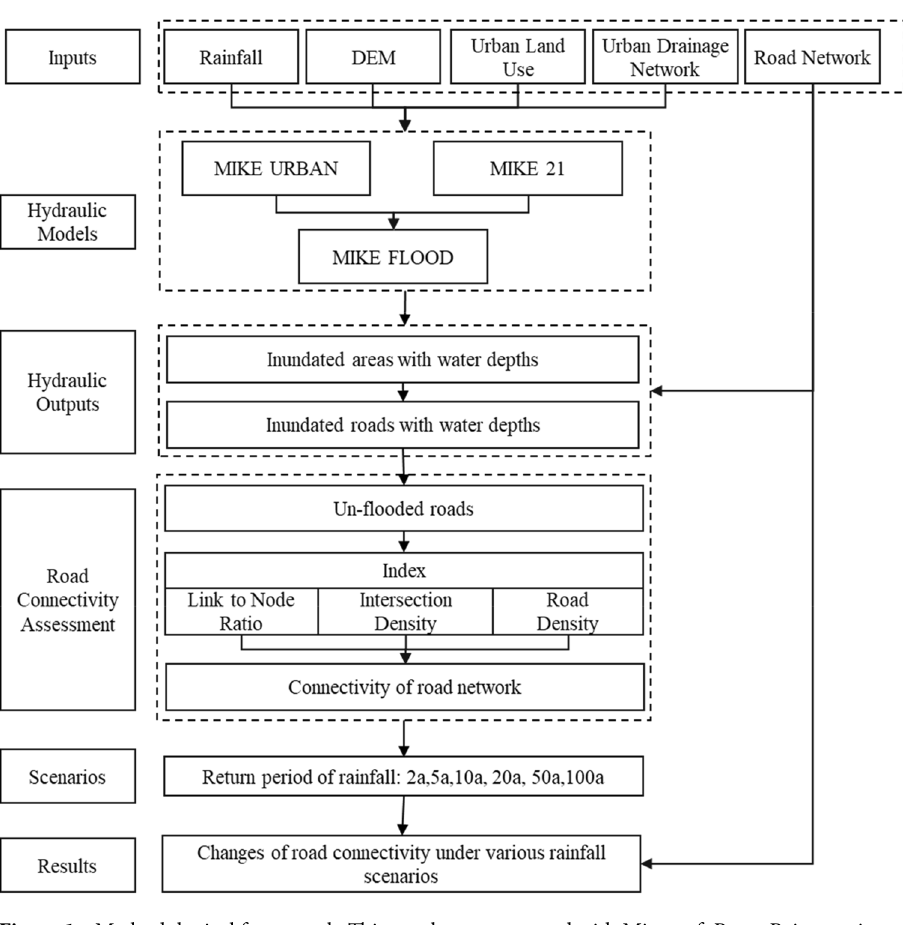
Figure 1. Methodological framework. This graph was generated with Microsoft PowerPoint version 2206(https:// www. office.